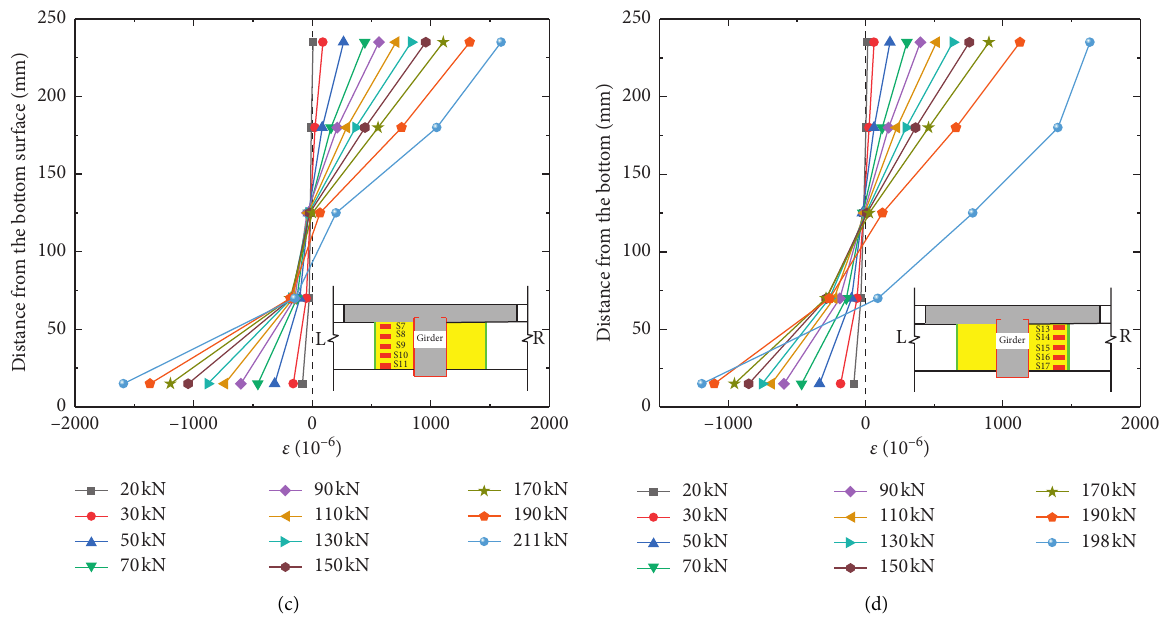
Figure 16: Strain distributions of GBJ1. (a) Beam section-L. (b) Beam section-R. (c) Shaped sleeve section-L. (d) Shaped sleeve